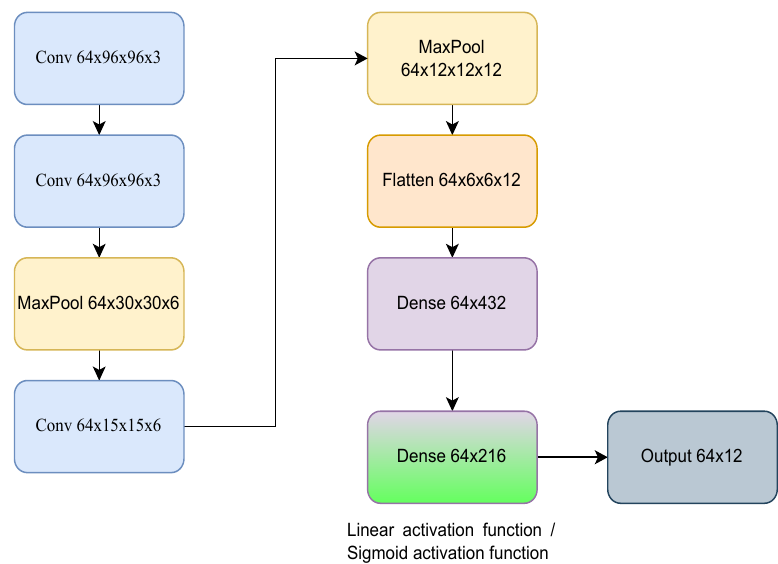
Figure 1. Diagram of the neural network used to calculate the Q-values using the DQN algorithm and the probability of success using the learning-based method. When computing the probability of success, the neural architecture used a sigmoid activation function in the last dense layer in order to restrict the output values between 0 and 1. Three consecutive 96 × 96 gray images of the car racing game are used as